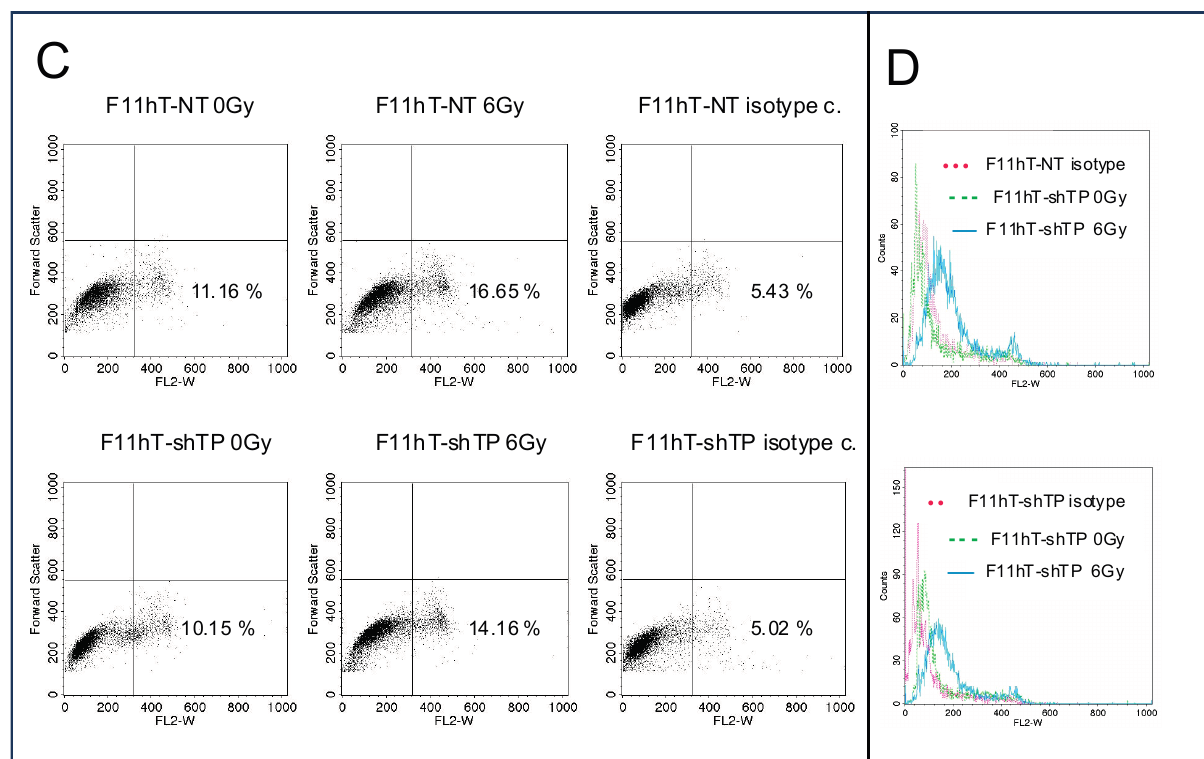
Figure 4. The effect of TP53inp1 silencing on the formation of radiation-induced autophagic vacuoles. ( A ) Quantitation of autophagic vacuoles shows a significant increase in the 6 Gy treated groups as compared to the sham irradiated F11hT-NT cells ( * p value < 0.5). Silencing of TP53inp1 is resulted significantly less autophagosome in 6 Gy-exposed F11hT-shTP cells ( * p value < 0.5). Two days after irradiation, cells were treated with Acridine Orange dye and red (autophagosome) puncta were counted from minimum eight cover slips ( n ≥ 8) under fluorescent microscope. White arrowheads denote the autophagic vacuoles. Results were analyzed with One-way ANOVA; ( B ) fluorescence photomicrograps obtained after Acridine Orange staining. Control cells (0 Gy) showing a few cytoplasmic AV formation, the number of AV increased in irradiated F11hT-NT cells and, to a lesser extent, in F11hT-shTP cells; ( C ) Representative flow cytometry plots are demonstrative of LC3B intracellular staining in response to 6 Gy exposures. Dot plot analysis is derived from the non-gated cell population. Flow cytometry analysis of F11hT-NT and F11hT-shTP cells using LC3B Antibody (Sigma, St. Louis, MI, USA) compared to a nonspecific isotype control antibody. Acquisition of 10,000 events was collected and for analysis the CellQuest software (BD Biosciences, San Jose, CA, USA) was used; ( D ) Representative flow cytometry histograms of percent LC3B-positive fibroblast are shown at right. Labeling of LC3B-positive cells at 48 h in F11hT-NT cells (right, top graph) and F11hT-shTP cells (right, bottom graph) after irradiation are